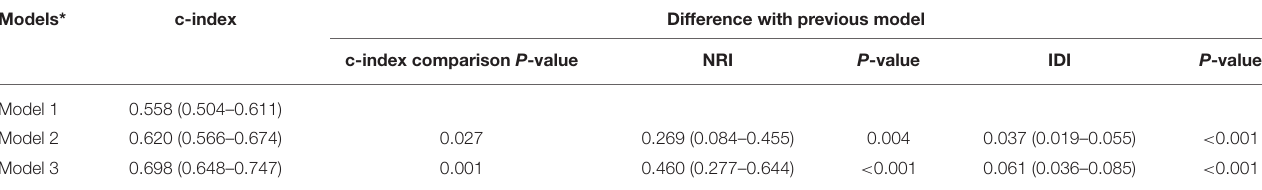
TABLE 4 | Comparison of prediction models for subsequent coronary